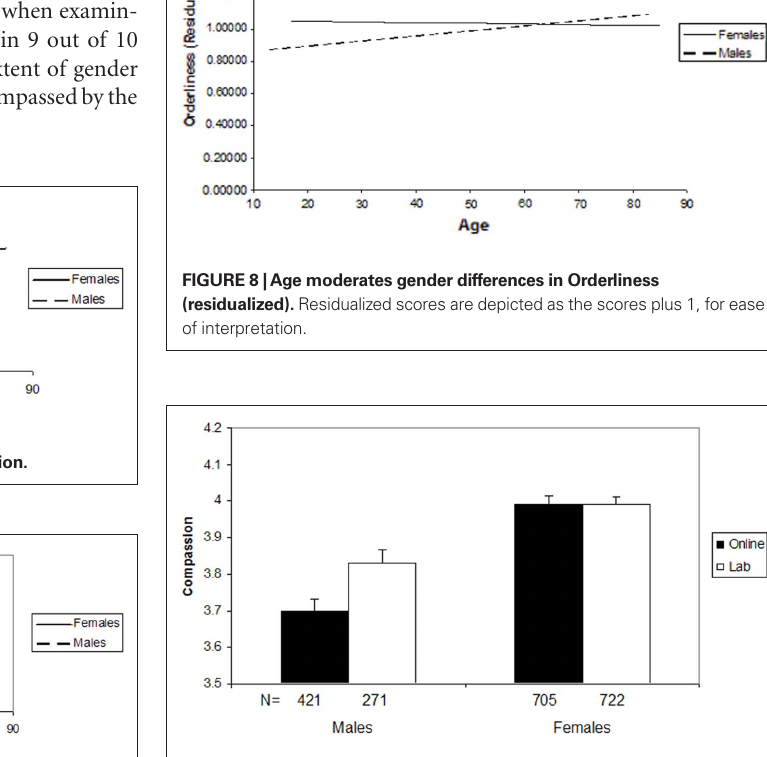
FIguRE 9 | Administration method moderates gender differences in